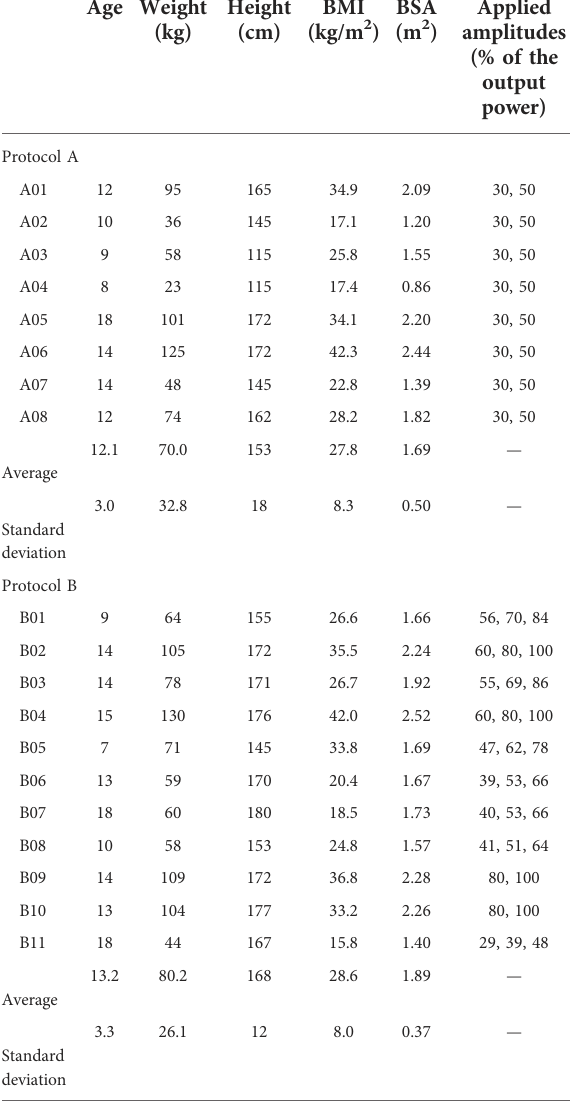
TABLE 1 Patients characteristics of the eight patients of protocol A and the eleven patients of protocol B. Age